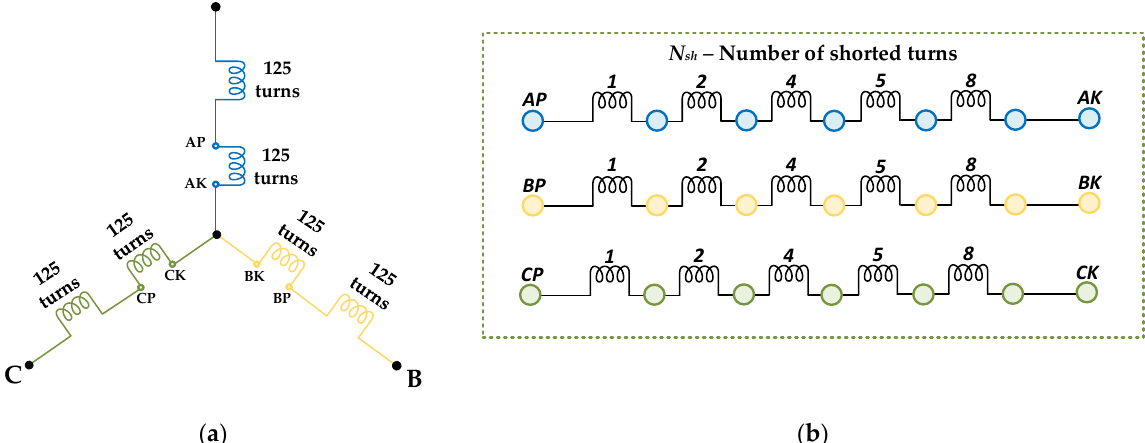
Figure 8. Block diagram of the experimental setup. The described experimental setup was used to collect the measurement data, which were used for training the proposed KNN classifier and its off-line verification but also for further on-line tests. The experimental studies were carried out for various load torque values in the range of (0 ÷ 1) T N with 0.2 T N step and for various rotational speeds (fre- quency of the supply voltage (60 ÷ 100) Hz). It allowed evaluating the influence of the motor operating conditions on the effectiveness of the fault classifier. 5. Training Process of the Proposed KNN Fault Classifier The effectiveness of the classifier model depends on the appropriate selection of its input vector elements, so they have to be carefully selected. This article proposes a spectral